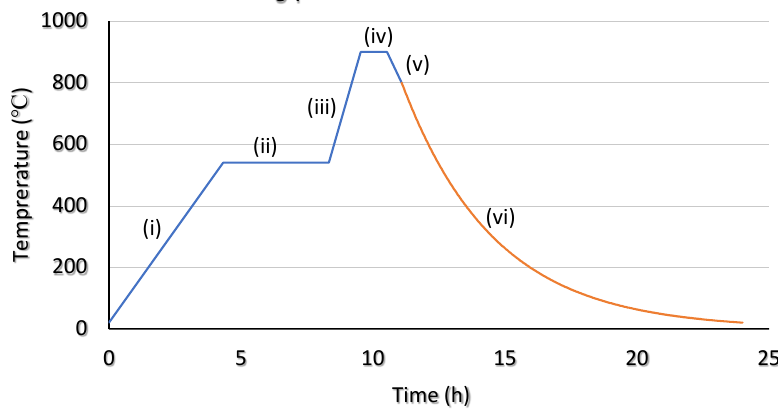
Figure 4. Sensor prototypes after firing.